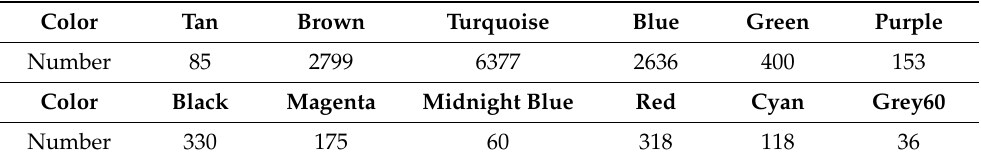
Table 1. Gene module and number of corresponding genes.